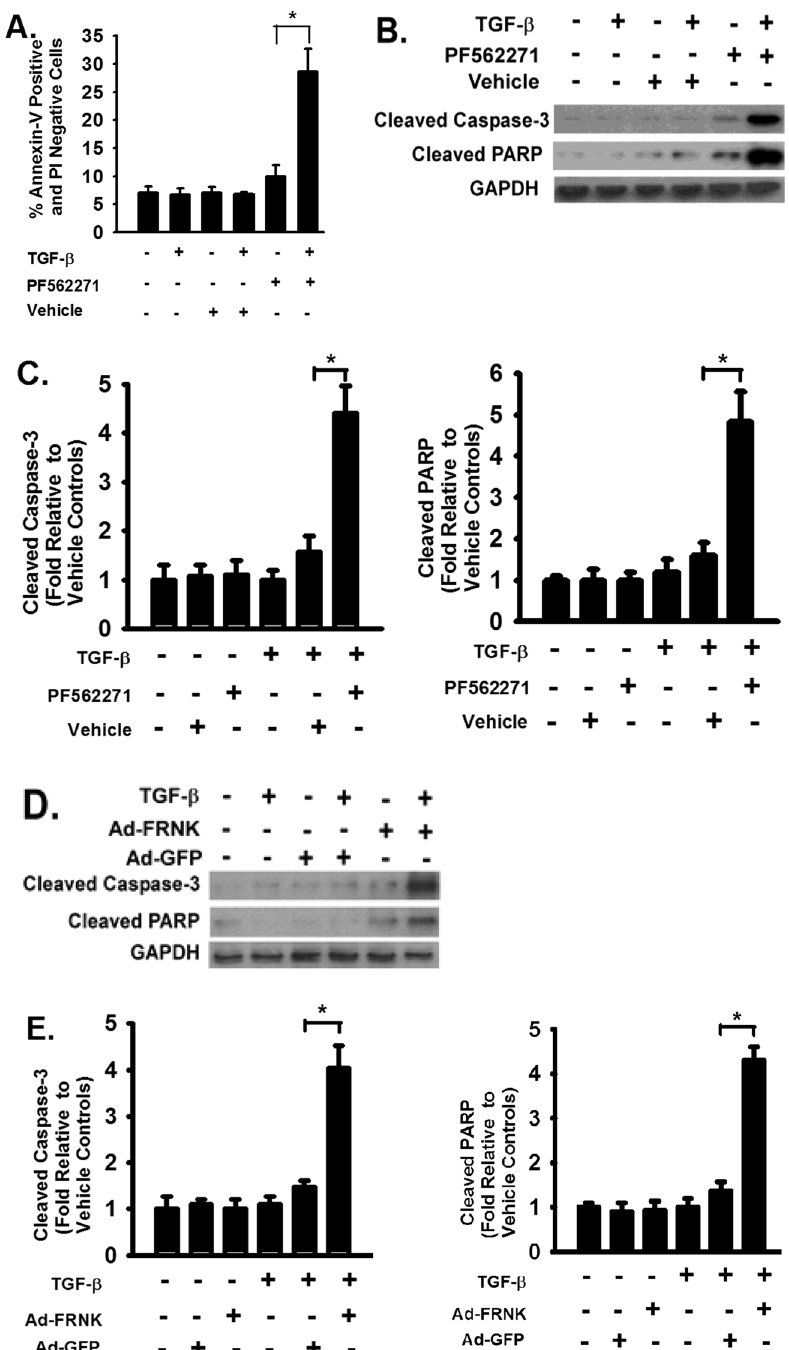
Figure 5. FAK inhibition induces apoptotic signaling in activated HSCs. ( A ) Primary mouse HSCs were treated with TGF- β 1 (2 ng/ml) followed by FAK inhibitor (PF562271, 0.5 µ M) for 24 hours and subject to Annexin-V and PI labeling apoptosis assays as described in Materials and Methods. The percentage of early apoptotic cells were marked by Annexin-V-positive and PI-negative. ( B ) HSCs were treated as in panel A and lysed at 24 hours. Equivalent amount of whole cell detergent lysates were Western blotted with antibody recognizing only cleaved caspase-3 or cleaved PARP for apoptotic signaling. ( C ) Densitometry analysis of the effect of FAK inhibitor on cleaved caspase-3 and PARP at the indicated condition. ( D ) HSCs were infected with adenoviral vectors containing FRNK or control GFP and treated as in panel A, then lysed at 24 hours followed by Western bot analysis with indicated antibodies as in panel B. ( E ) Densitometry analysis of the effect of FRNK expression on cleaved caspase-3 and PARP at the indicated condition. Data were pooled from three independent experiments and represented as mean ± SE. * p represents <